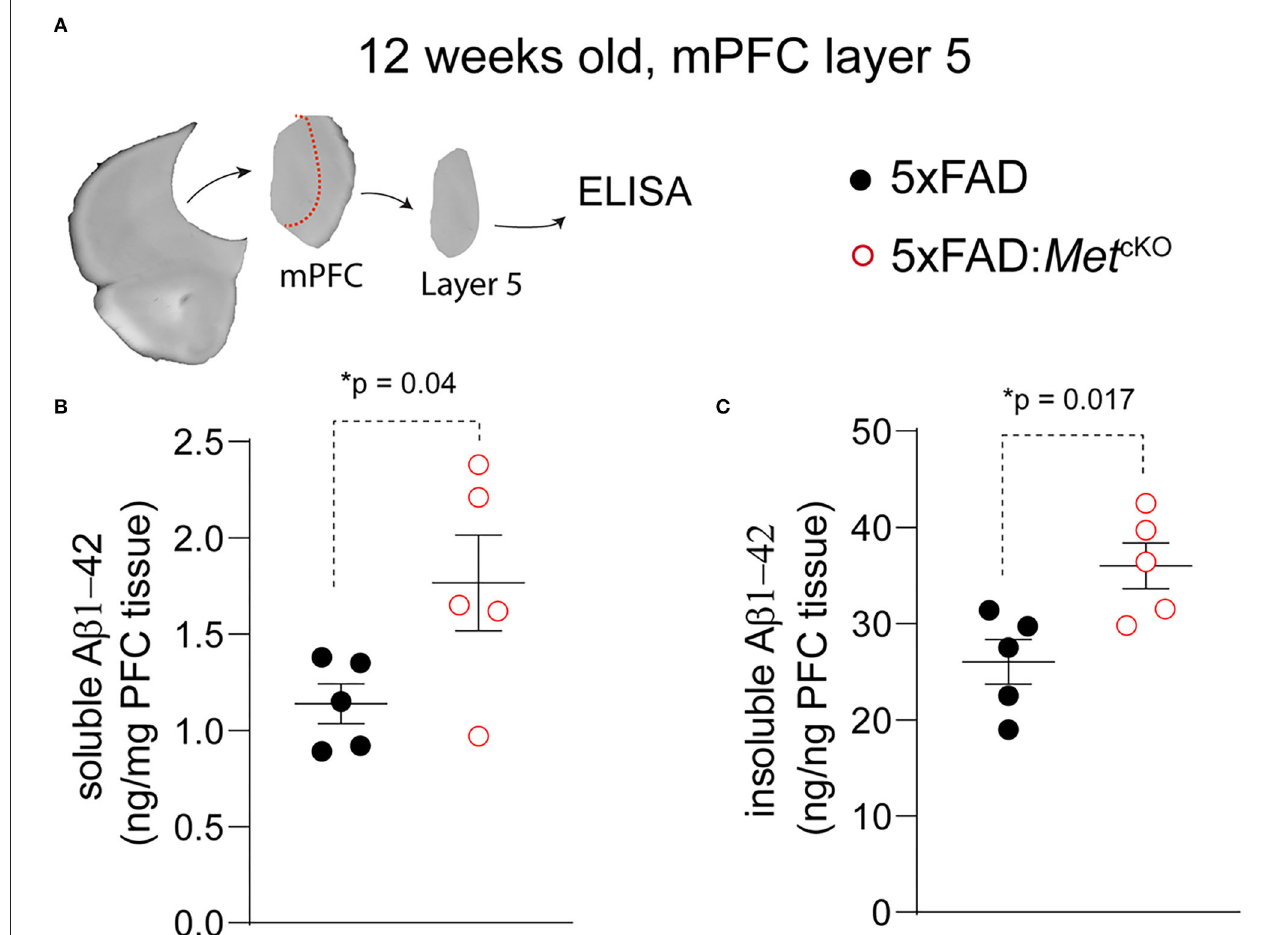
FIGURE 3 | Genetic ablation of MET signaling increases A β production in 5XFAD mice. (A) Schematic illustration of micro-dissected mPFC L5 tissues that are used for ELISA measurement of A β 1 − 42 . (B) 5XFAD: Met cKO mice L5 mPFC tissues show significantly increased soluble forms of A β 1 − 42 (* p = 0.04). (C) Compared to 5XFAD tissues, 5XFAD: Met cKO mice L5 mPFC tissue shows significantly increased insoluble forms of A β 1 − 42 (* p = 0.017).